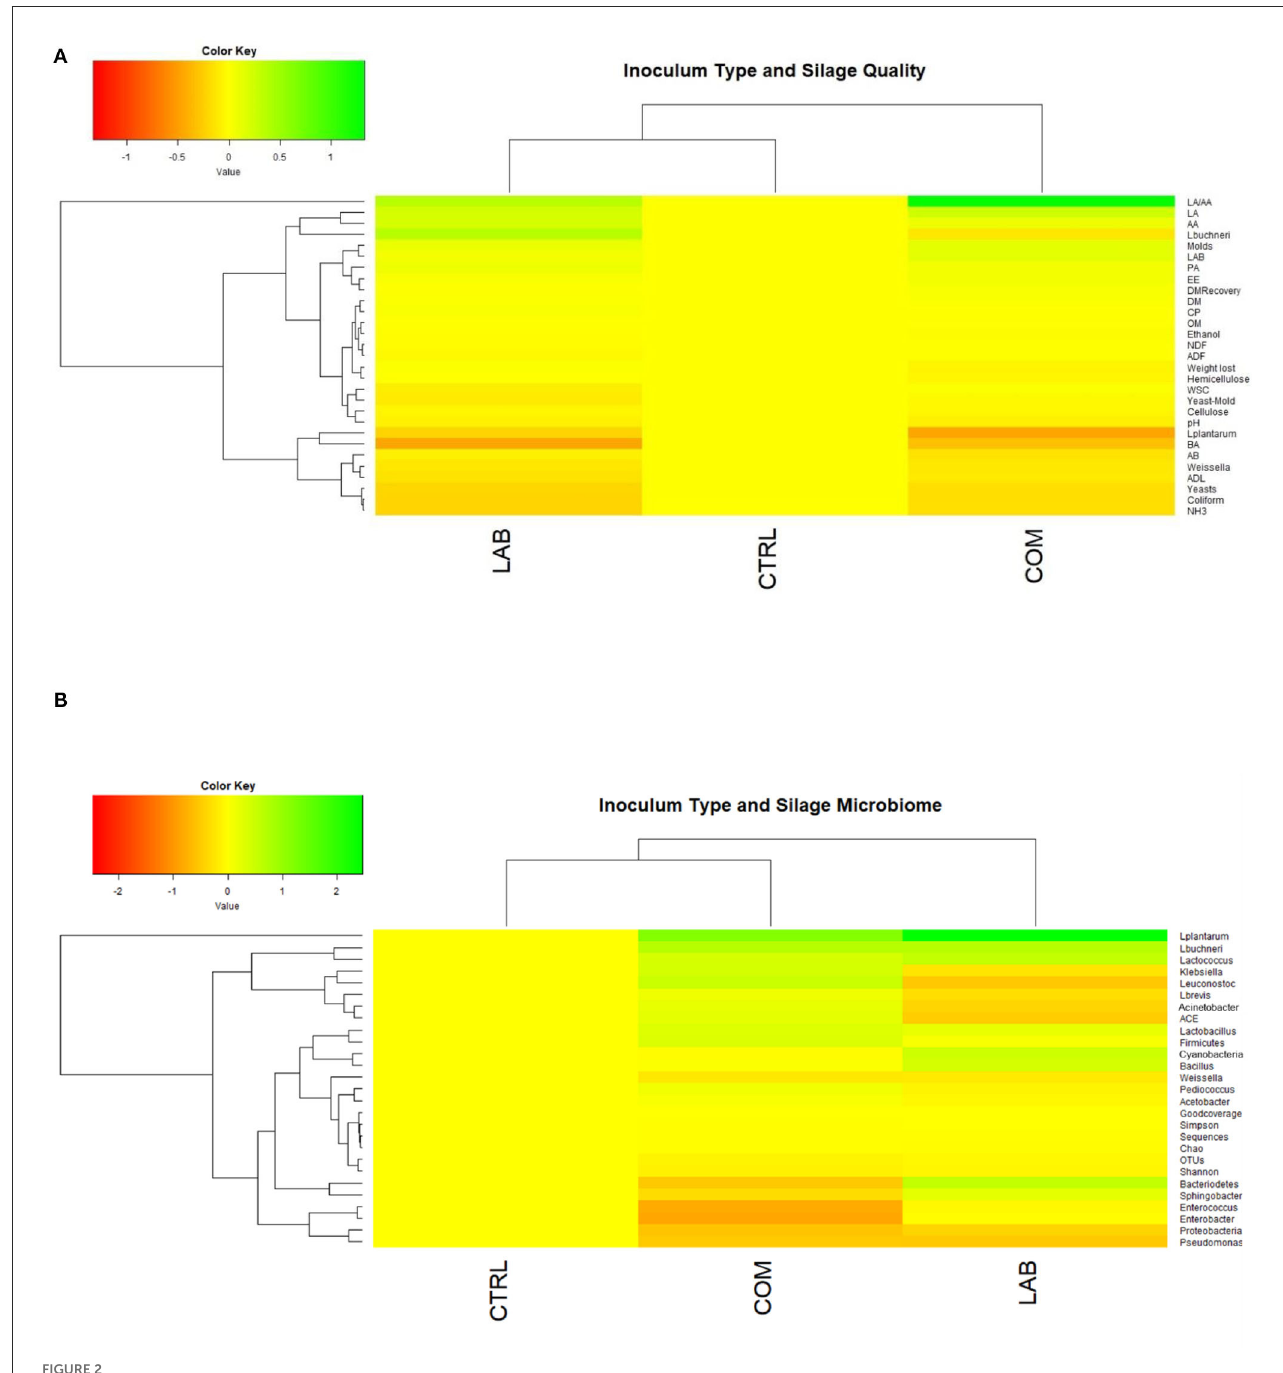
FIGURE2 Dendro-heatmap visualized the relationship patterns between inoculum types addition with silage quality (A) and between inoculum types addition with silage microbiome (B) . Colors key indicates the treatment effect from declining (red) to increasing (green) compared to the control. CTRL, control treatment without lactic acid bacterial inoculant; LAB, lactic acid bacteria addition; COM, the addition combining different lactic acid bacterial types. DM, dry matter; OM, organic matter; CP, crude protein; NDF, neutral detergent fiber; ADF, acid detergent fiber; EE, ether extract; WSC,